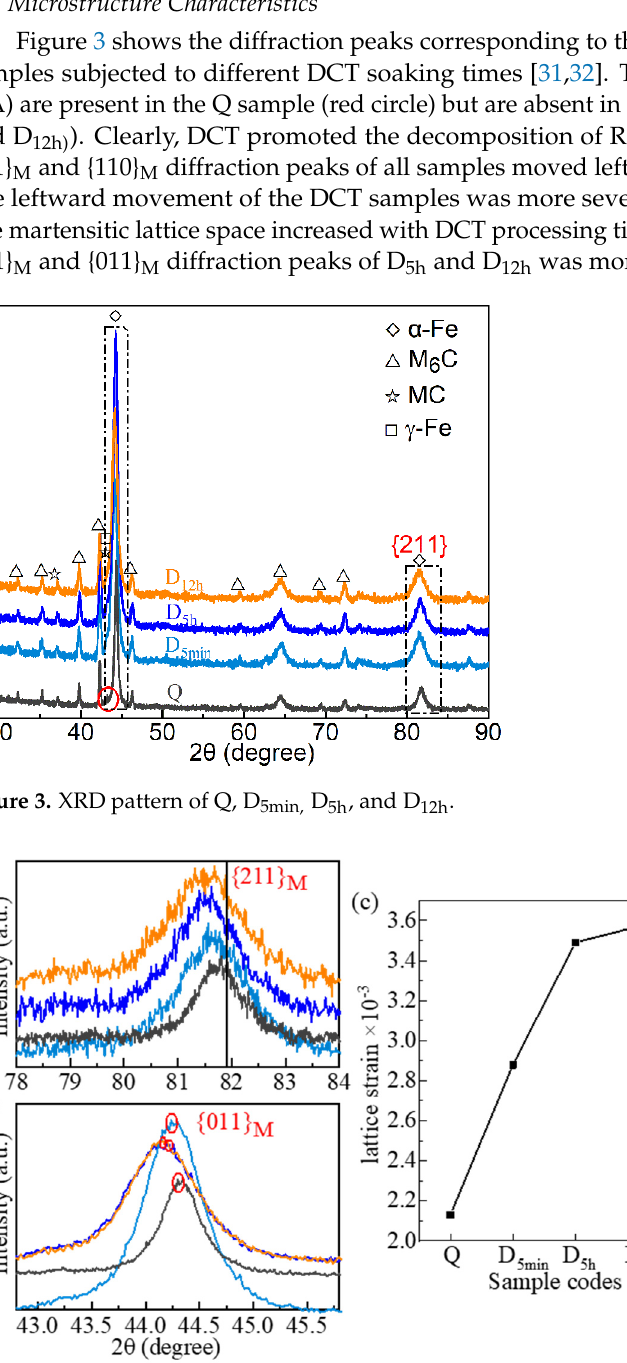
Figure 4. Enlarged view of ( a ) {211} M and ( b ) {011} M diffraction peaks, and ( c ) the lattice strain of {211} M